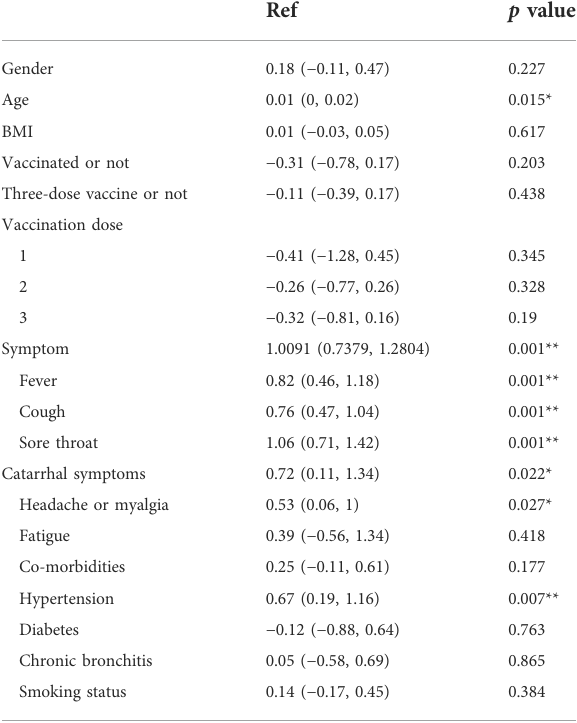
TABLE 4 Correlation analysis of independent factors and COVID-19 test negative